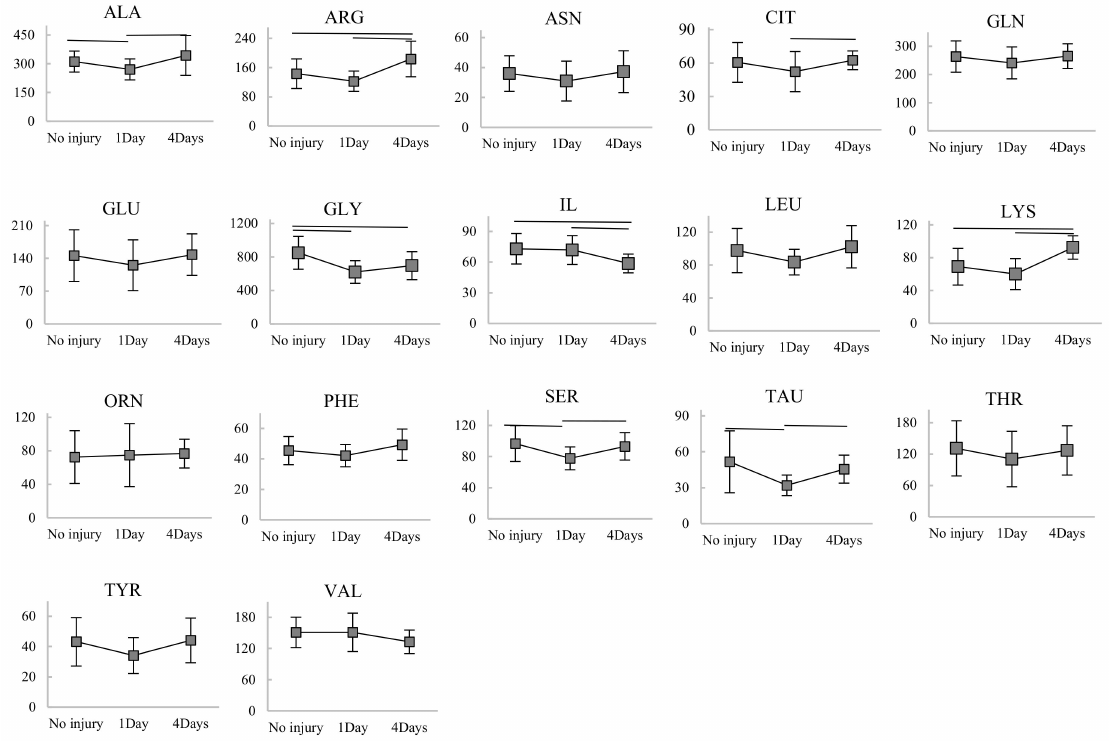
Figure 2. Alteration of serum concentrations (in nm / mL) of amino acids over time after TBI (in the Development dataset). Statistically significant di ff erences in the concentrations of amino acids between time points are noted with horizontal